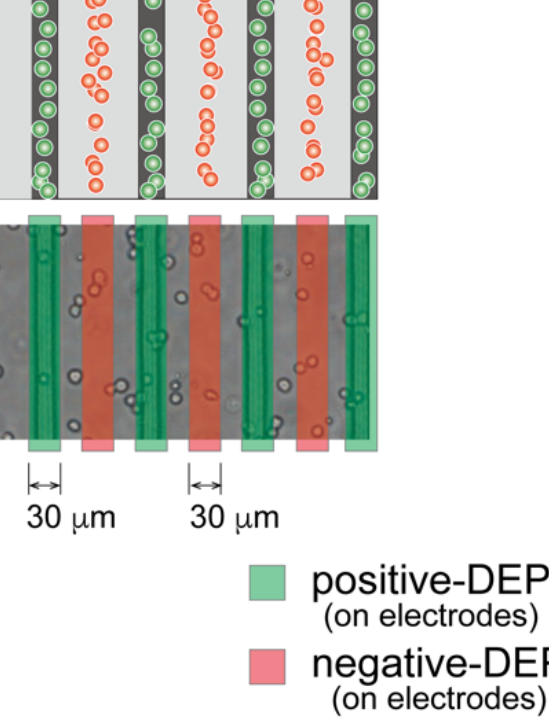
Figure 3. Evaluation of the dielectrophoretic property of chondrocytes. After dielectrophoresis, cells in red regions demonstrated a negative-DEP response, whereas those in green regions demonstrated positive-DEP response.